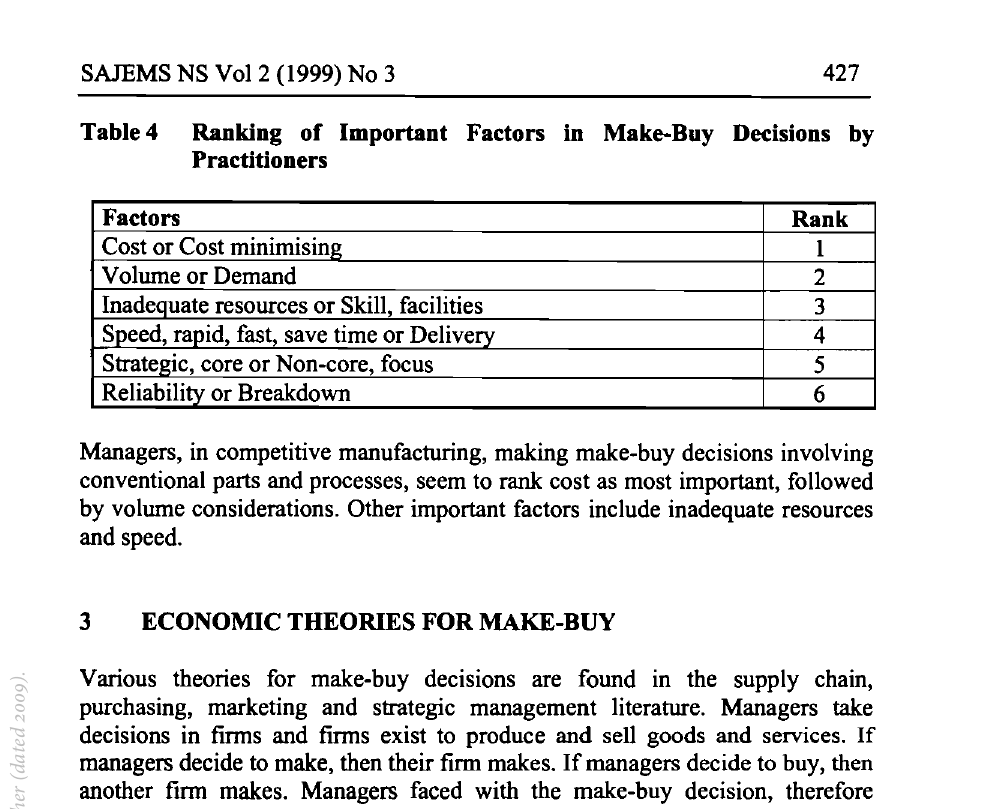
Ranking of Important Factors in Make-Buy Decisions by